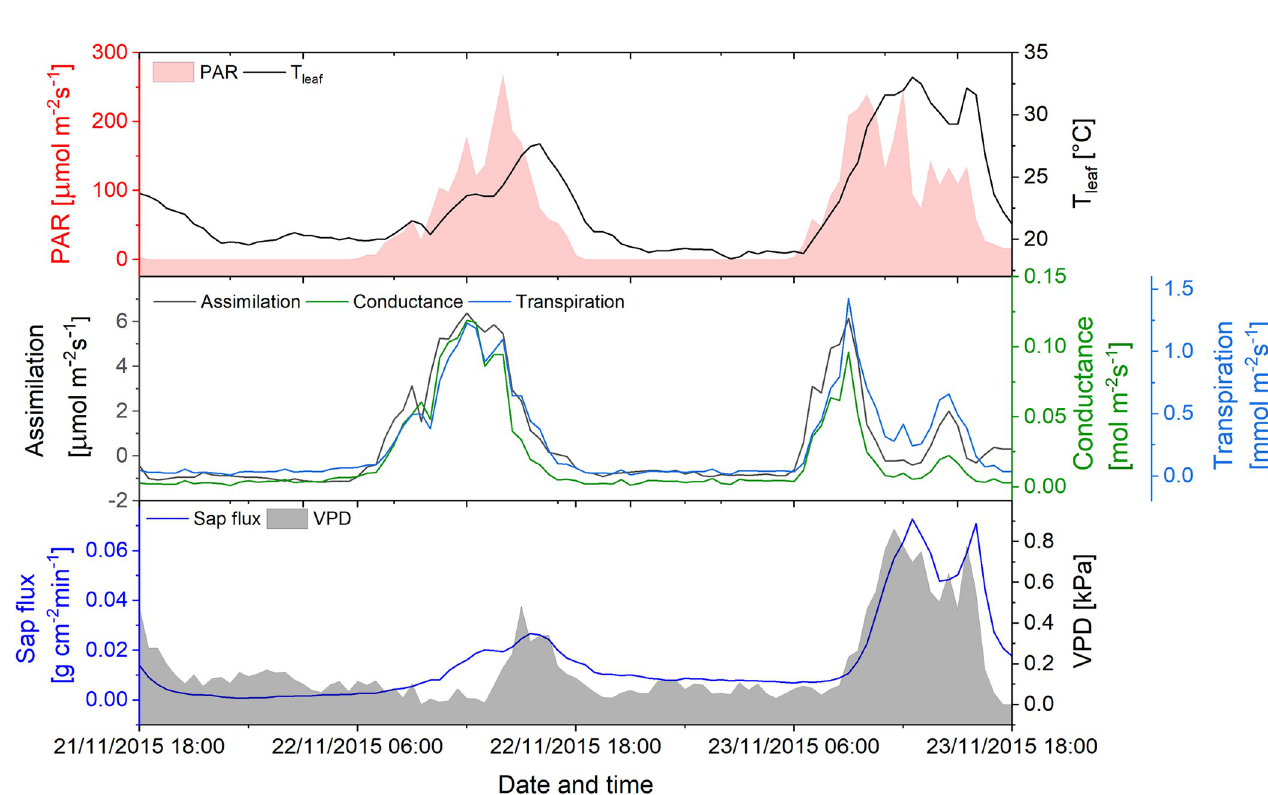
Fig 8. Leaf gas exchange on the background of microclimate parameters (VPD and PAR) of Ocotea aciphylla , measured over 2 days (November 21–23, 2015) under atmospheric conditions simulated as close to natural as possible with the IRGA.